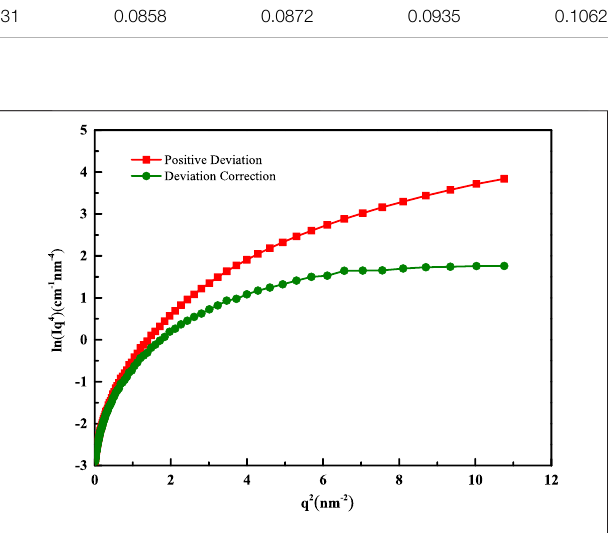
FIGURE 1 | Scattering curves of eight coal samples with different ranks. FIGURE 2 | Porod ’ s curve deviation correction for sample (GS sample